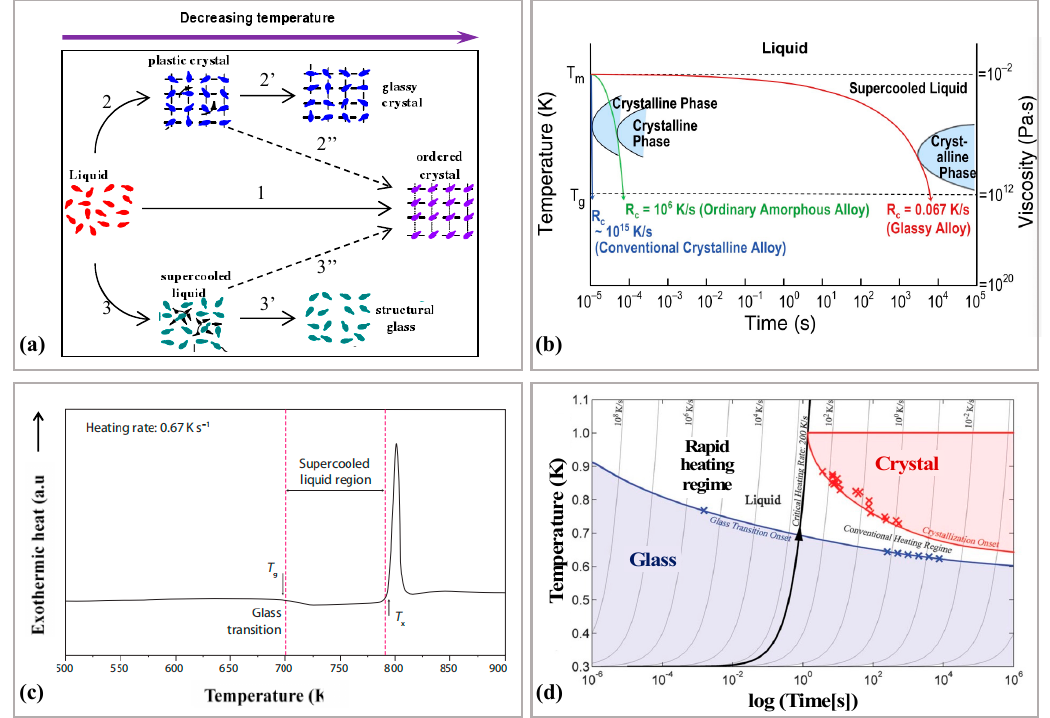
Figure 5. ( a ) Schematic diagram of the structural evolution of the different states of matter obtained by liquid cooling, adapted with permission from Ref. [49] 2019, Wang et al. ( b ) The rapid cooling process of amorphous matter, adapted with permission from Ref. [37] 2017, APS. ( c ) The DSC curve of BMG, the left red line is T g, the middle of the red lines is the supercooled liquid region, and the right red line is T x, adapted with permission from Ref. [29] 2011, nature. ( d ) The critical heating rate to completely bypass crystallization on heating from the glass through the liquid is about 200 K/s. Using the millisecond heating method, which enables heating rates on the order of 106 K/s, the undercooled liquid is accessible at any temperature above the glass transition, through the melting point and beyond, where the liquid enters the equilibrium state (upper left quadrant in the diagram), adapted with permission from Ref. [50] 2005,